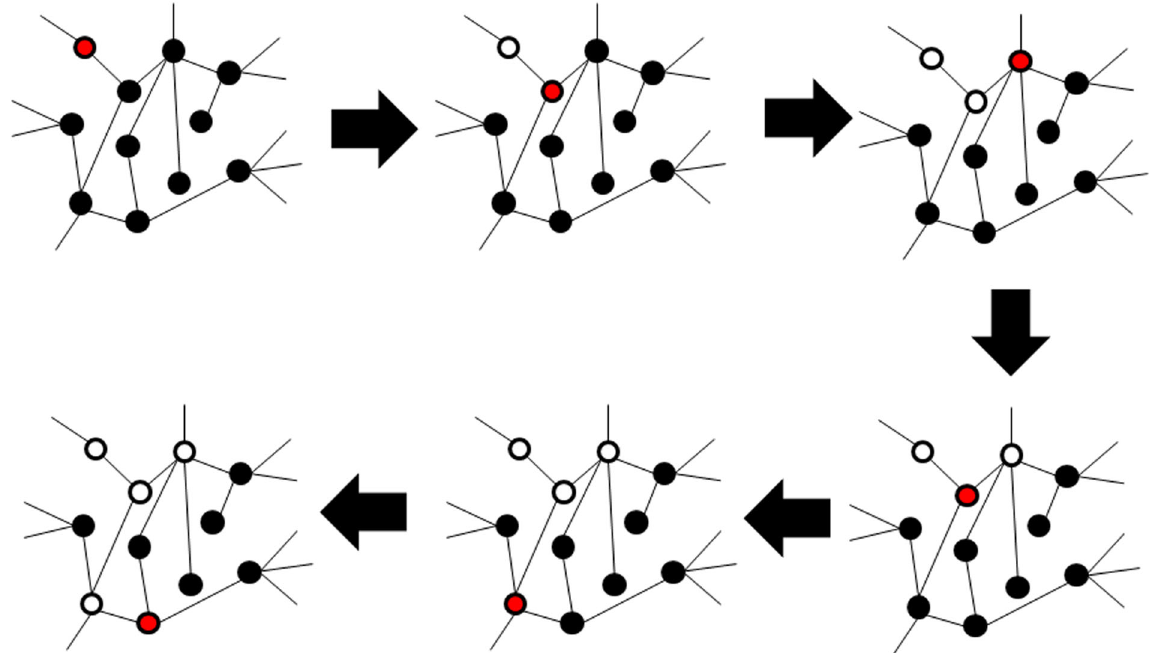
Fig. 1 A schematic diagram showing the behavior of a solitary-type actor in the resource patch network. The nodes and links represent the resource patch network. Filled circles are patches with resources whereas open circles are patches with no resources. Here the actor (shown as red) travels freely in the resource patch network and takes resources when he encounters